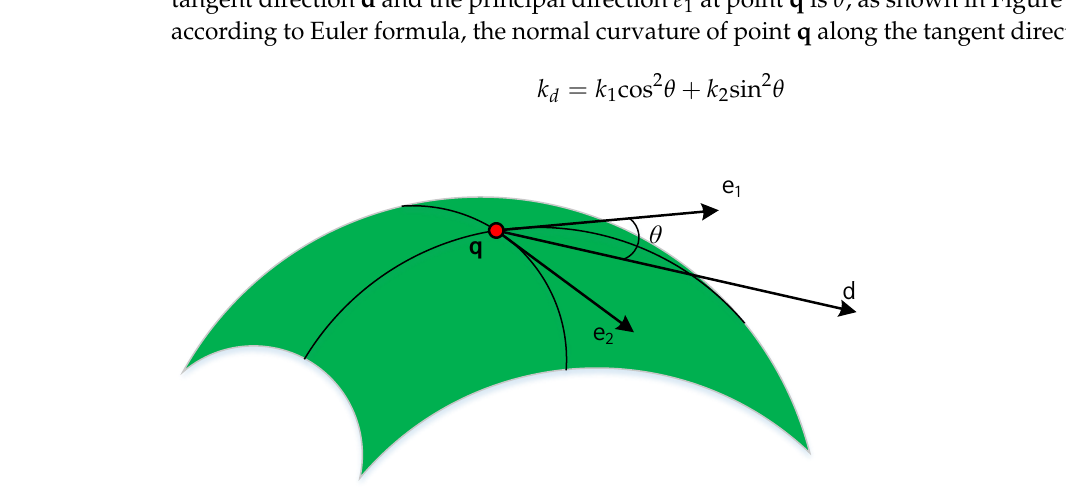
Figure 5. Principal direction and tangent direction.